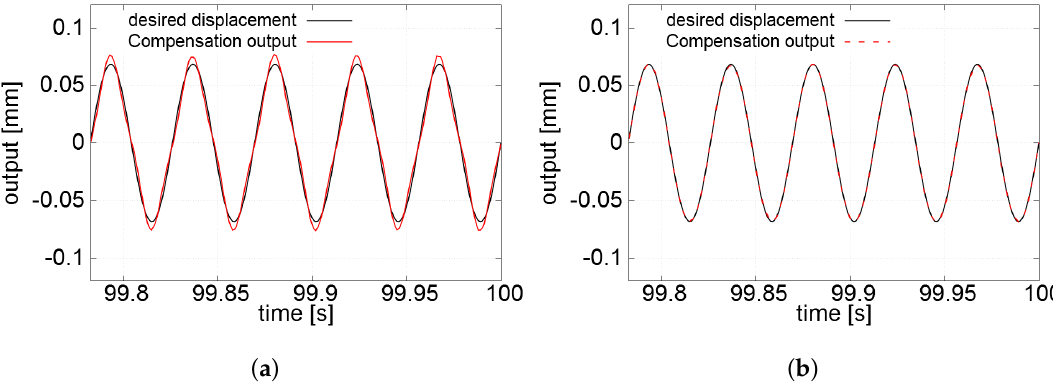
Figure 17. Time domain comparison of the output displacement of the piezoelectric actuator and the reference trajectory. ( a ) Result of compensation for 23 Hz input: control input is synthesized with only (16) and (17); ( b ) Result of compensation for 23 Hz input: control input is synthesized with the proposed control law